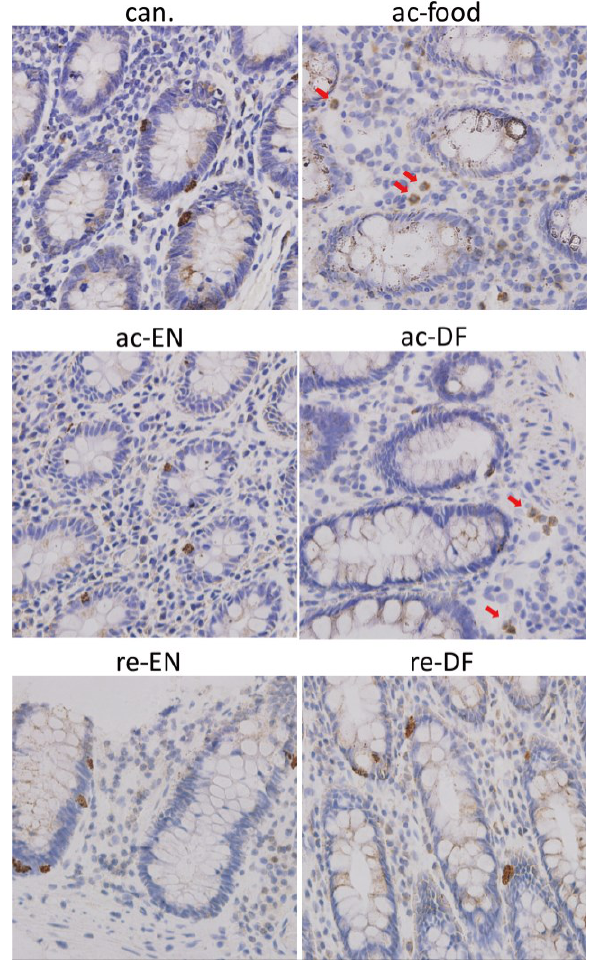
Figure 6. Immunohistochemistry showed the expression of G-protein coupled receptor